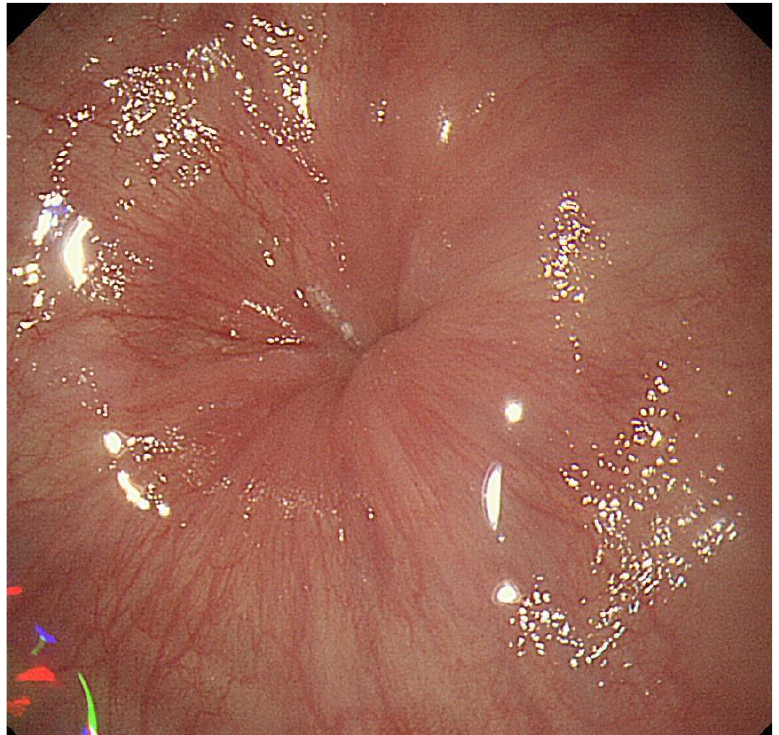
Figure 3. A case with achalasia in which Champagne glass sign was observed. Gingko leaf sign was observed at the esophago-gastric junction during deep inspiration.